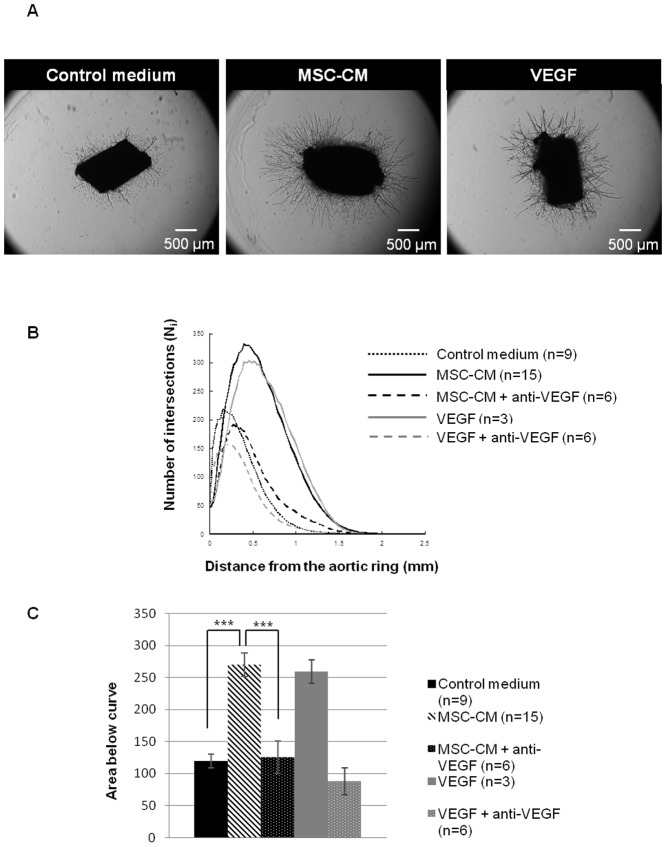
BMSC-CM promotes angiogenesis in vitro.(A) Representative photomicrographs of rat aortic rings after 9 days in culture medium containing 5% control medium, 5% BMSC-CM or 20 ng/ml of rat VEGF. (B) Quantification of number of intersections (Ni) of neovessels treated with 5% control medium, 5% BMSC-CM and 20 ng/ml VEGF, with or without 1 µg/ml anti-VEGF. (C) Area below curves generated for each condition by the semi-assisted computerized quantification. Presence of BMSC-CM significantly favours angiogenesis and this effect is mediated by VEGF. Experiment was repeated 3 to 15 times. *** p<0.001.